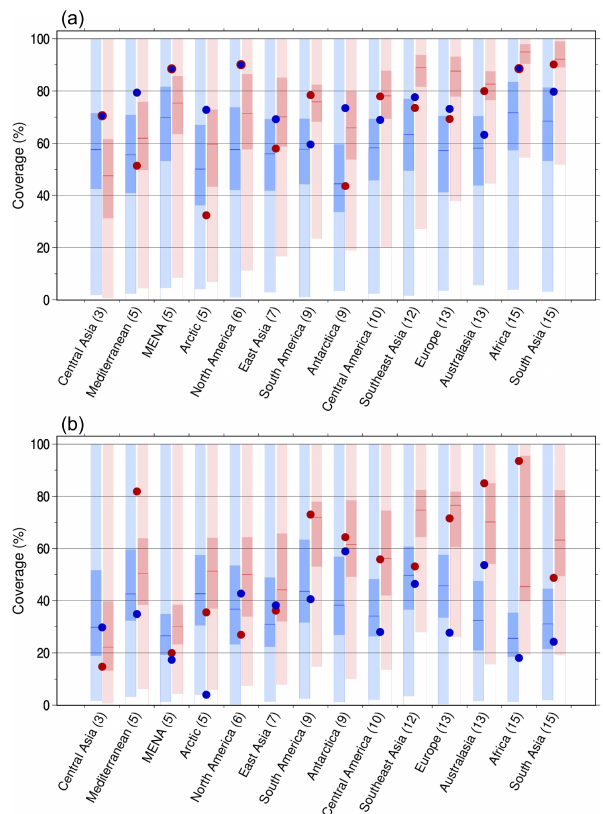
Figure 4. Coverage performance of the ISIMIP and CORDEX sub- sets compared with the range of the full set of CMIP5 models for (a) annual mean temperature increment and (b) precipitation change scaled to the regional mean temperature increment. Blue and red dots indicate the coverage (FRA) in ISIMIP and CORDEX respec- tively for each region. Blue bars indicate the spread of FRA when four models, as in ISIMIP, are selected randomly in 10000 times. Red bars indicate the spread when randomly selecting the same number of models as in CORDEX, e.g. 10 models in Central Amer- ica. The full range of the coloured bars indicates the minimum-to- maximum coverage of the FRA spread. Dark blue and red bars in- dicate the 25th to 75th percentile range. Horizontal lines in the dark blue and red parts indicate the median. Numbers in parentheses are the number of models used in